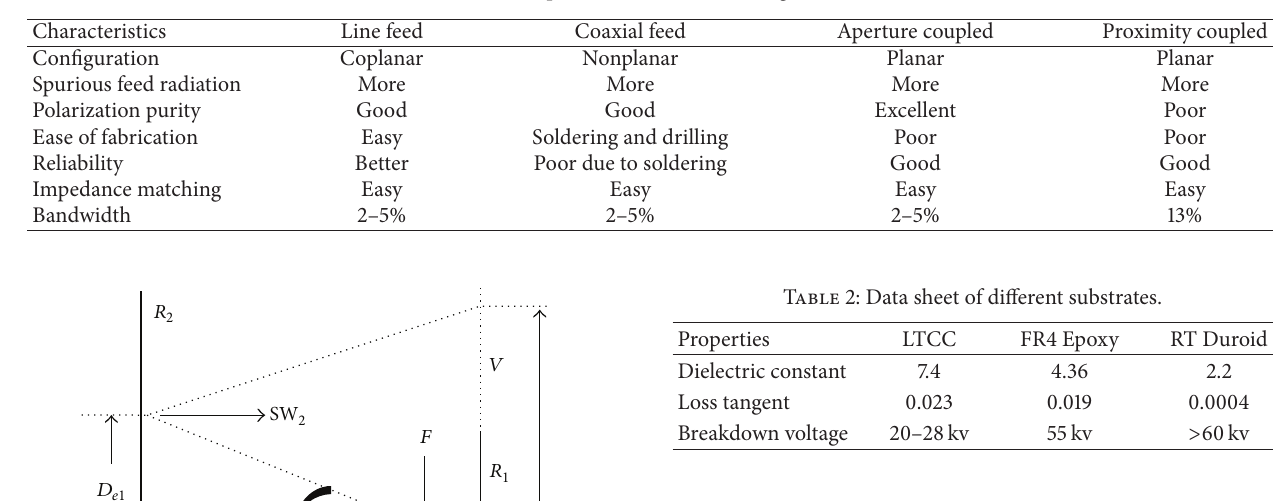
Table 1: Comparison of different feeding methods.